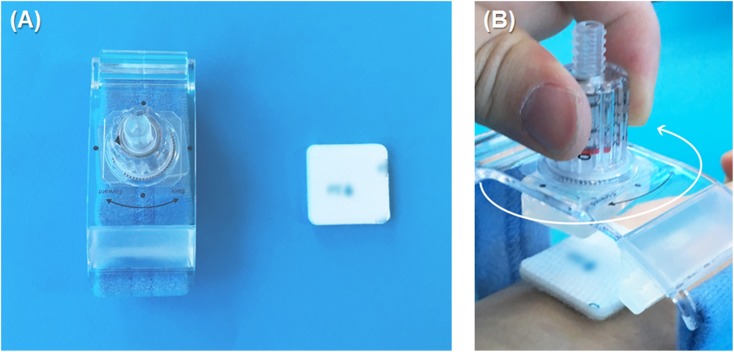
Study devices.(A) Both rotatory compression device and hemostasis pad were used for the patients in the study group. (B) After placing the hemostasis pad over the puncture site, the rotatory compression device was applied.